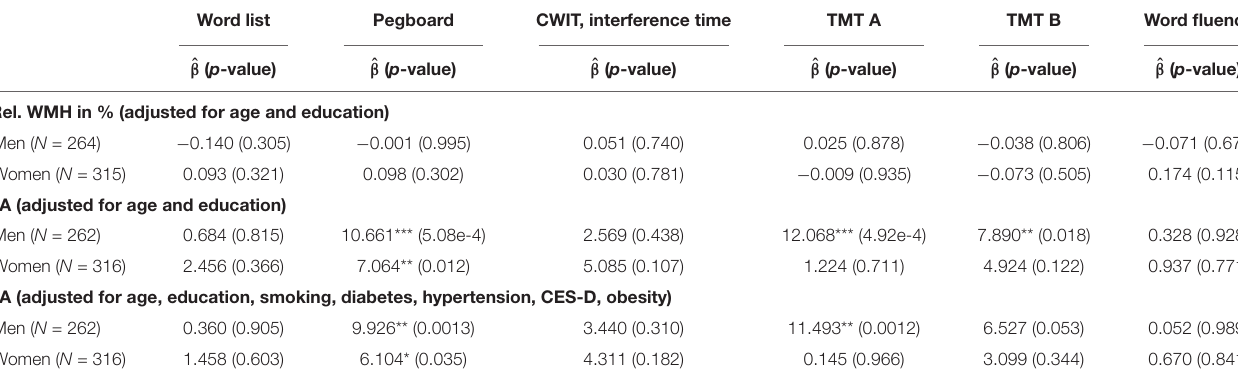
TABLE 5 | Association of WMH and FA, respectively, with cognitive test results ( Z